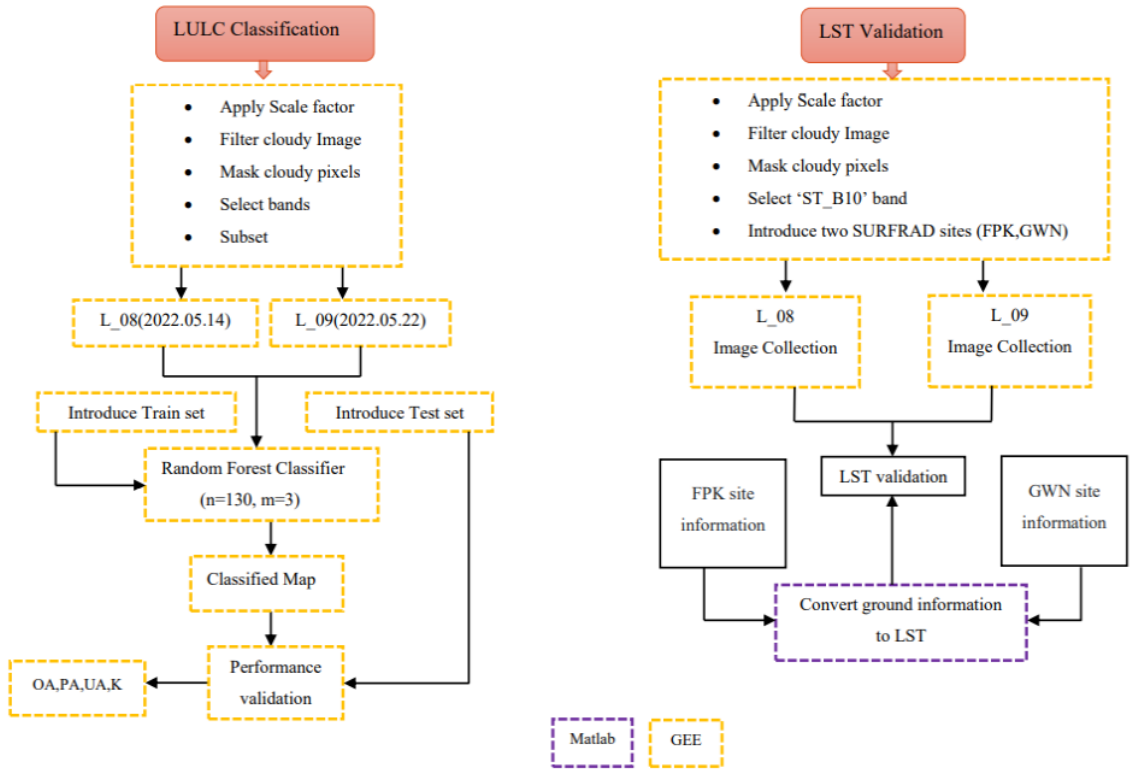
Figure 3. General workflow of this